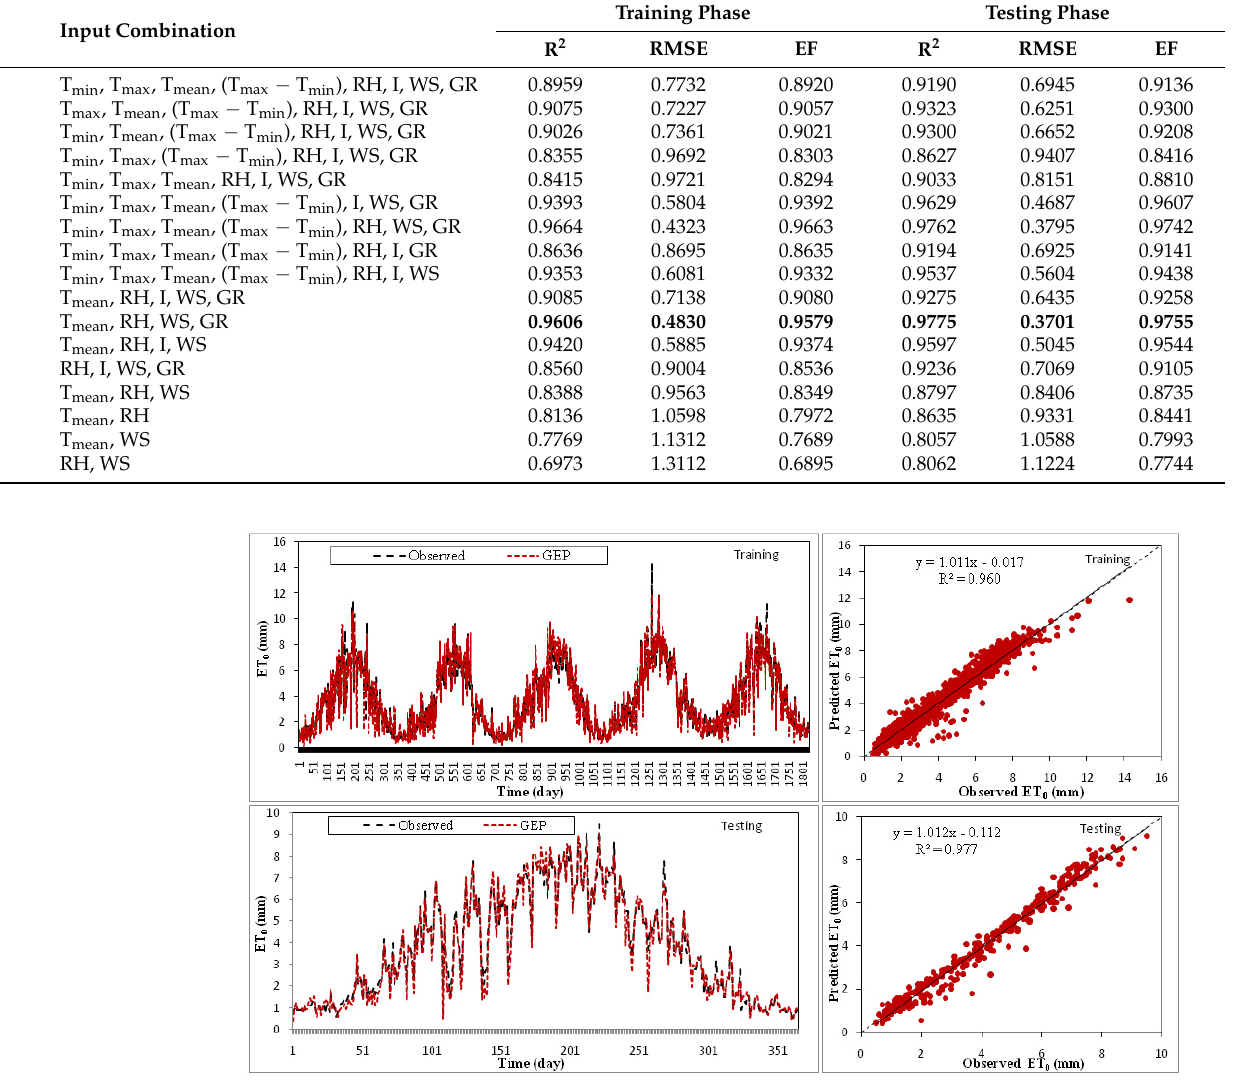
Figure 7. Performance of the optimum combination of inputs/ best input combination based model GEP M11 model for both training and testing stages.